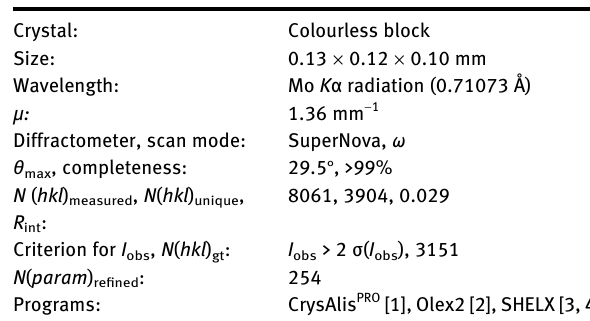
Table  : Data collection and